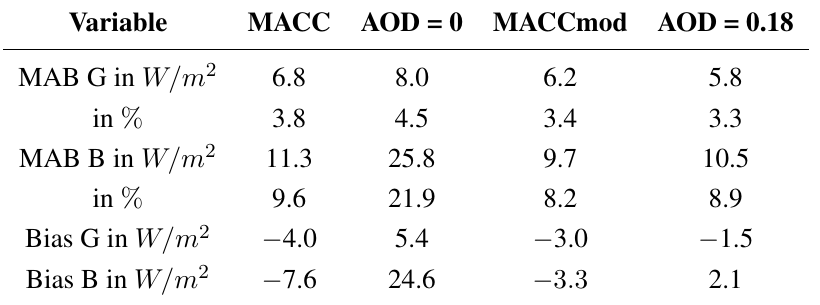
Table 3. Mean Absolute Bias (MAB) over all stations for global irradiance G and direct (beam) irradiance B in absolute units [ W/m 2 ] and relative units, MAB deviation relative to the mean [%] . The last two lines show the bias in W/m 2 . The AOD = 0 and AOD = 0.18 columns provide the results for zero and 0.18 AOD of tropospheric